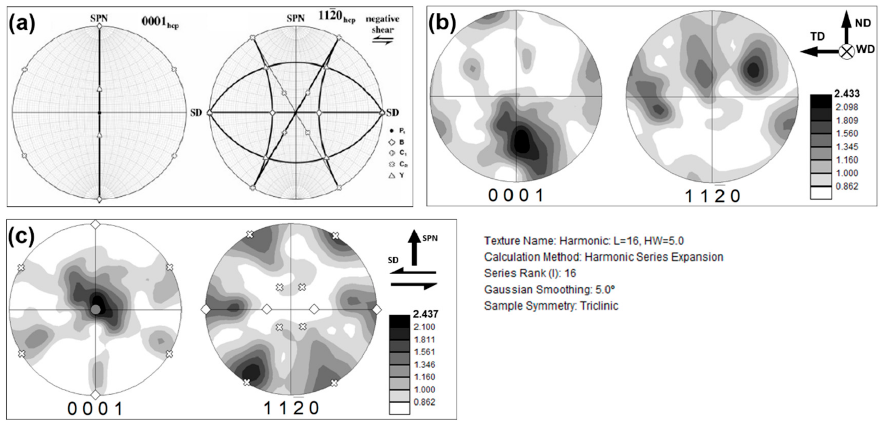
Figure 6. {0001} and {1120} pole figures showing ( a ) ideal simple-shear textures expected for hexagonal close packed metals (after Fonda, et al. [48]), ( b ) those derived from Figure 4a, and ( c ) those derived from Figure 4a which were rotated 50° about the TD and then 15° about the ND to align with the presumed geometry of simple shear. For comparison purposes, several ideal simple-shear orientations are indicated in ( c ).